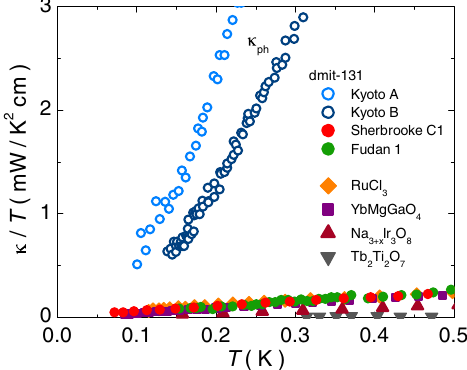
FIG. 5. Thermal conductivity κ =T vs T for dmit-131, as reported by the Kyoto group [10], the Fudan group [18], and in the present work. For the Kyoto data, the residual linear term has been subtracted so that the data reflect only the phonon contribution κ . For comparison, thermal conductivity data for ph the spin-liquid materials RuCl 3 [17], YbMgGaO 4 [16], Na 3 þ x Ir 3 O 8 [15], and Tb 2 Ti 2 O 7 [14] are also plotted. These are all insulators, so the thermal conductivity is entirely phononic and is at least 20 times smaller than κ in the Kyoto data. ph